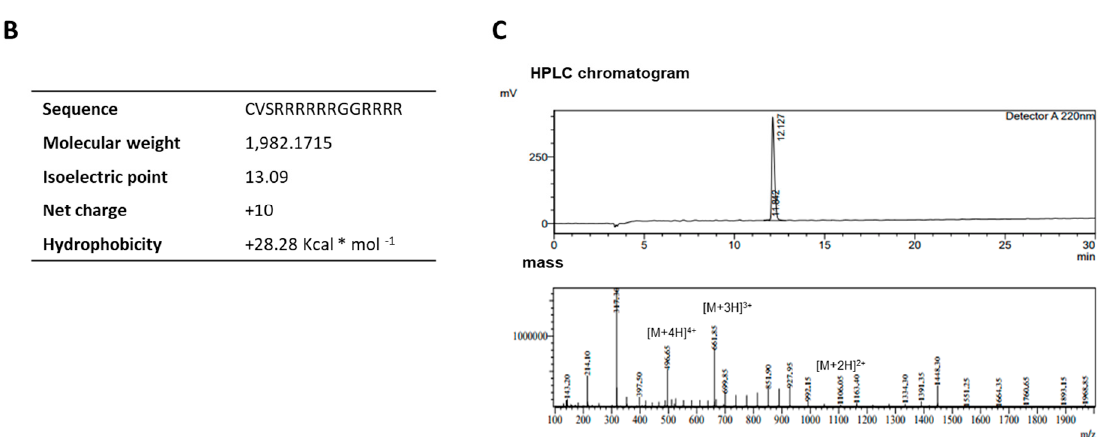
Figure 1. Synthesis of the LMWP cell-permeable peptide. ( A ) The primary and secondary structure of LMWP. ( B ) Sequence information of the synthesized LMWP. ( C ) HPLC chromatogram peak and mass value of LMWP.